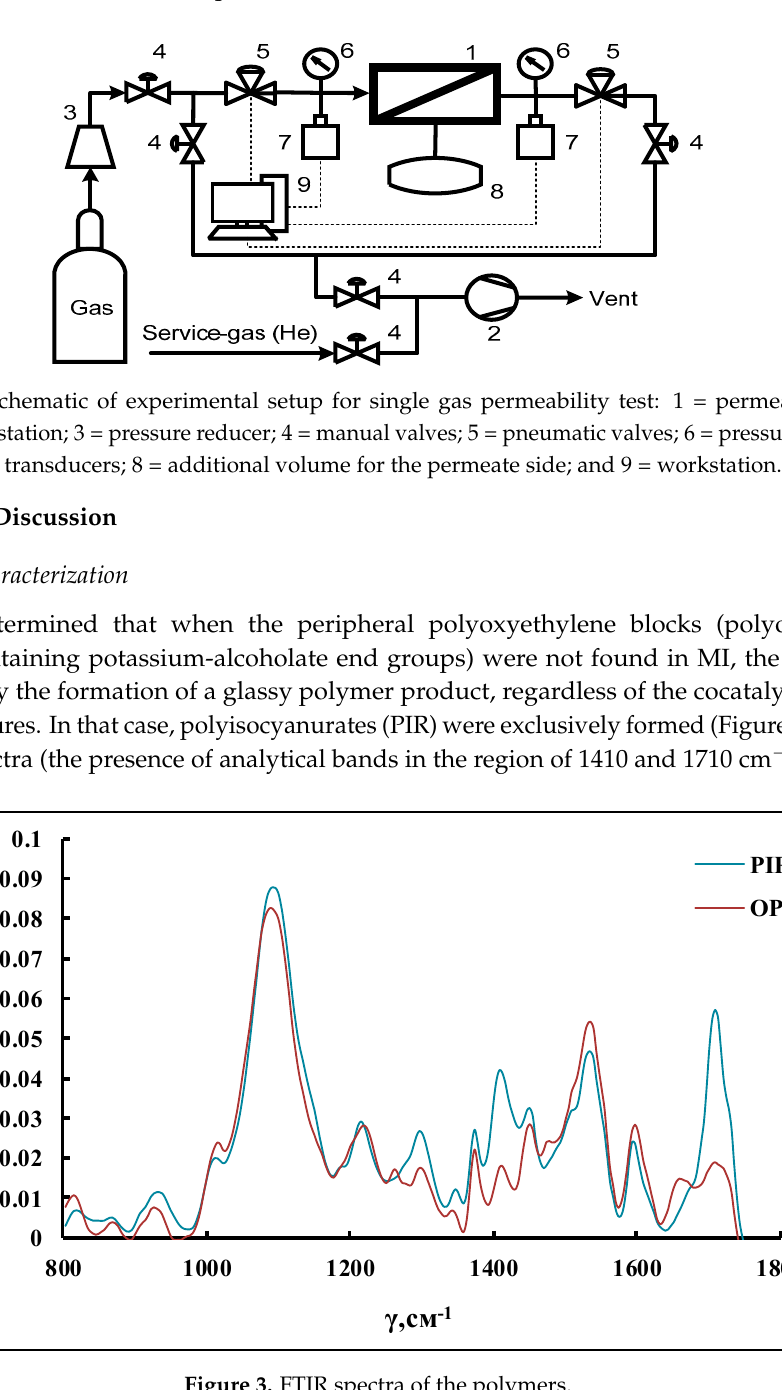
Figure 3. FTIR spectra of the polymers.